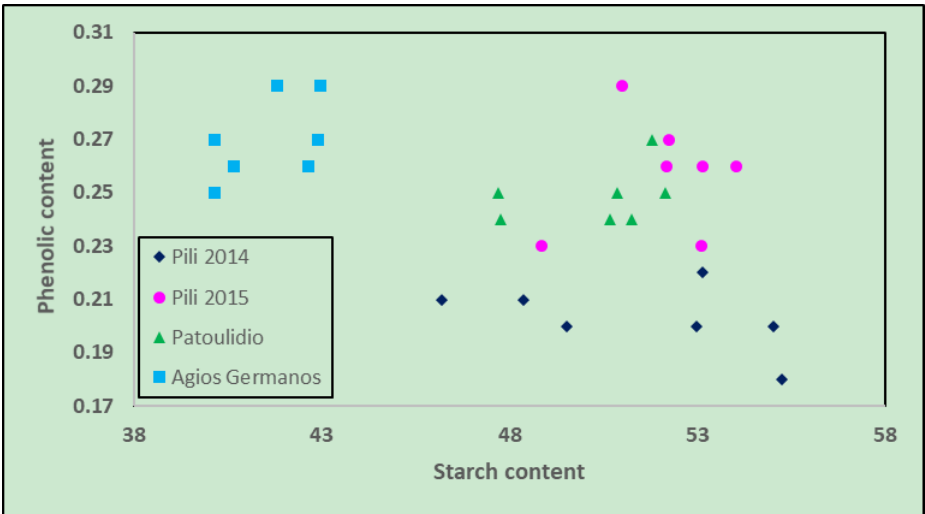
Figure 3. Chart of phenol content versus Starch content